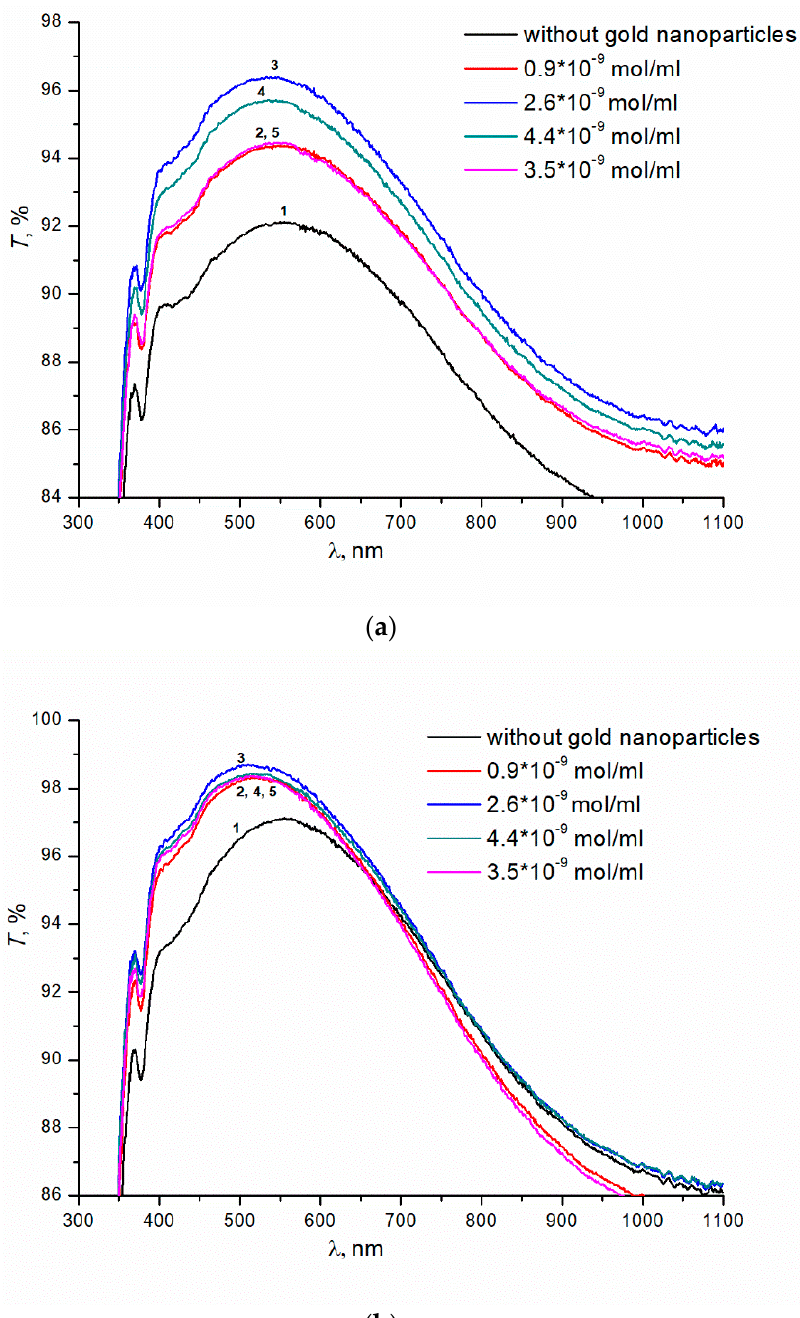
Figure 3. ( a ) Transmittance of silicate glass with the coatings obtained from sols of silicon dioxide with the addition of TBAB (5 wt.%) and gold nanoparticles of various concentrations. Annealing temperatures of gel at 200 °C, 1 h. ( b ) Transmittance of silicate glass with the coatings obtained from sols of silicon dioxide with the addition of TBAB (5 wt.%) and gold nanoparticles of various concentrations. Annealing temperatures of gel at 250 °C, 1 h.